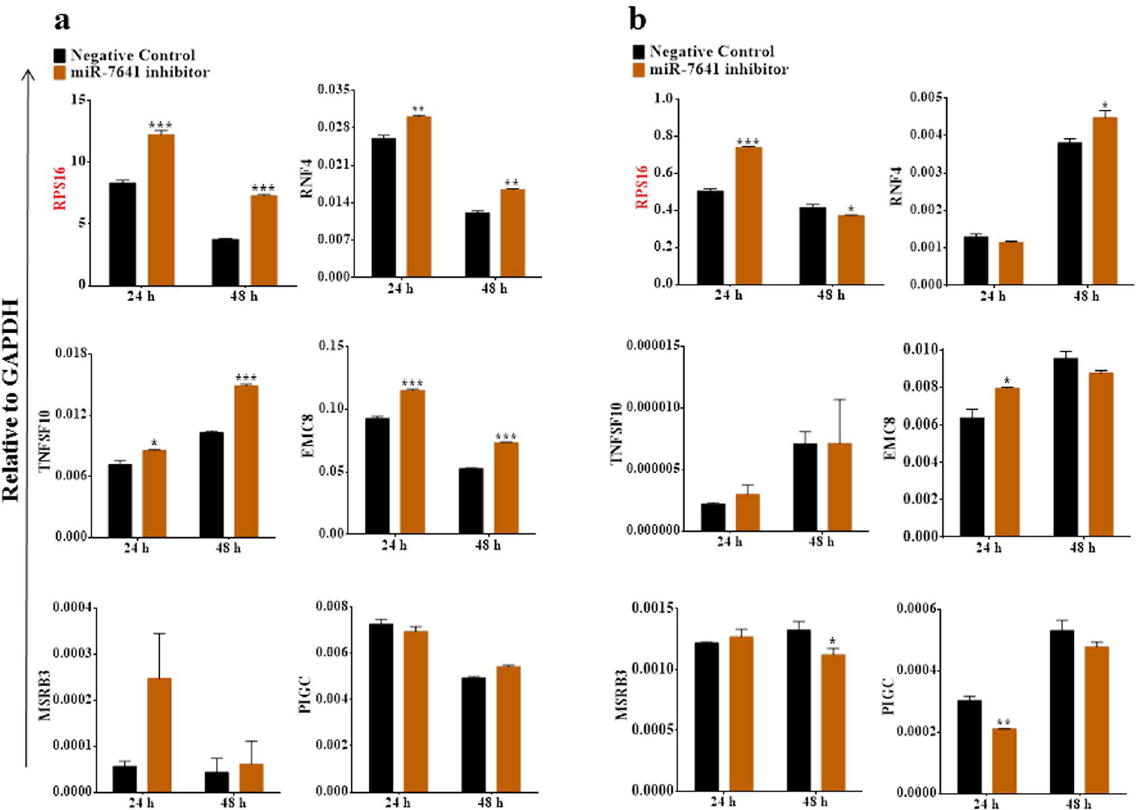
Figure 5. Inhibition of miR-7641 altered target gene expression in colon cancer cells. ( a ) Bar diagrams presenting the expression patterns of miR-7641 target genes in HT-29 colon cancer cells upon transfection with a locked nucleic acid inhibitor against miR-7641. Inhibition of miR-7641 resulted in the upregulation of RPS16 , RNF4 , TNFSF10 , and EMC8 expression. ( b ) Bar diagrams showing that inhibition of miR-7641 upregulated RPS16 , RNF4 , and EMC8 expression in HCT116 colon cancer cells. Bar diagrams show the mean ± SD obtained from triplicate experiments. * p < 0.05, ** p < 0.01, and *** p <